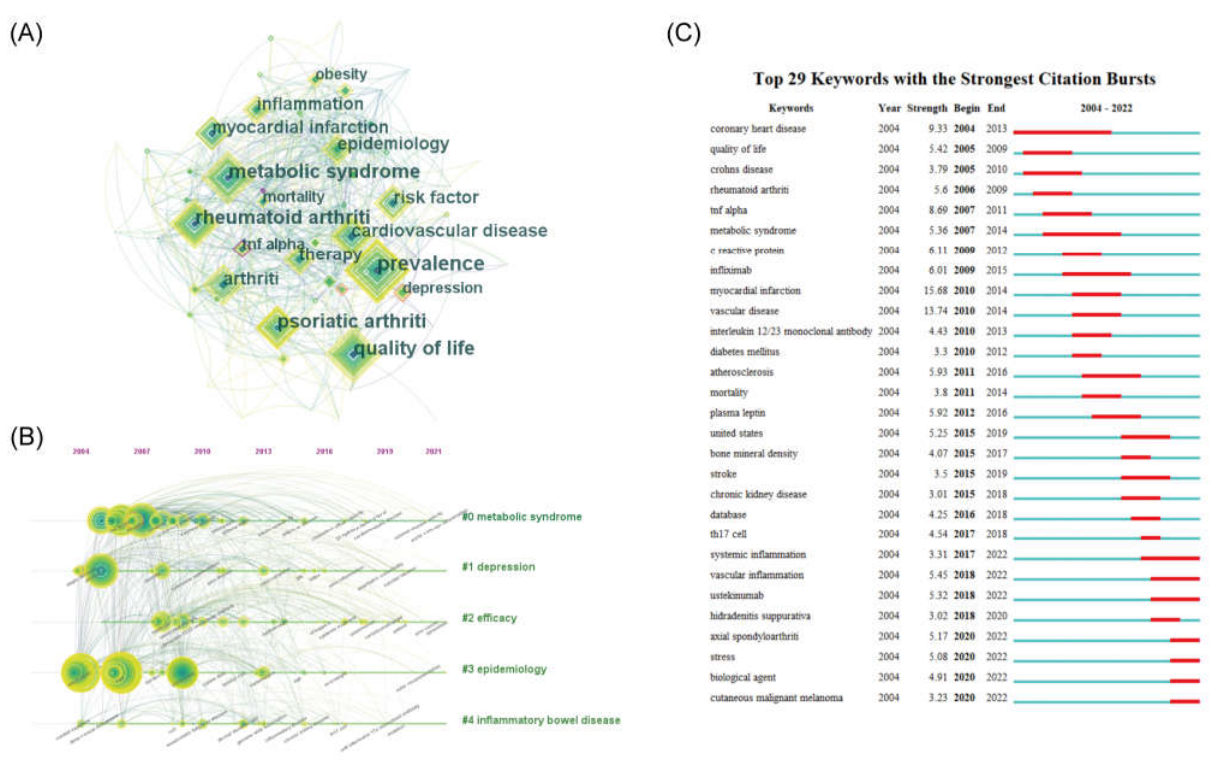
Figure 5. Keywords in psoriasis co-morbidities. ( A ) The co-occurrence network of keywords ( B ) Timeline for clustering of keywords ( C ) The top 29 most bursting keywords.